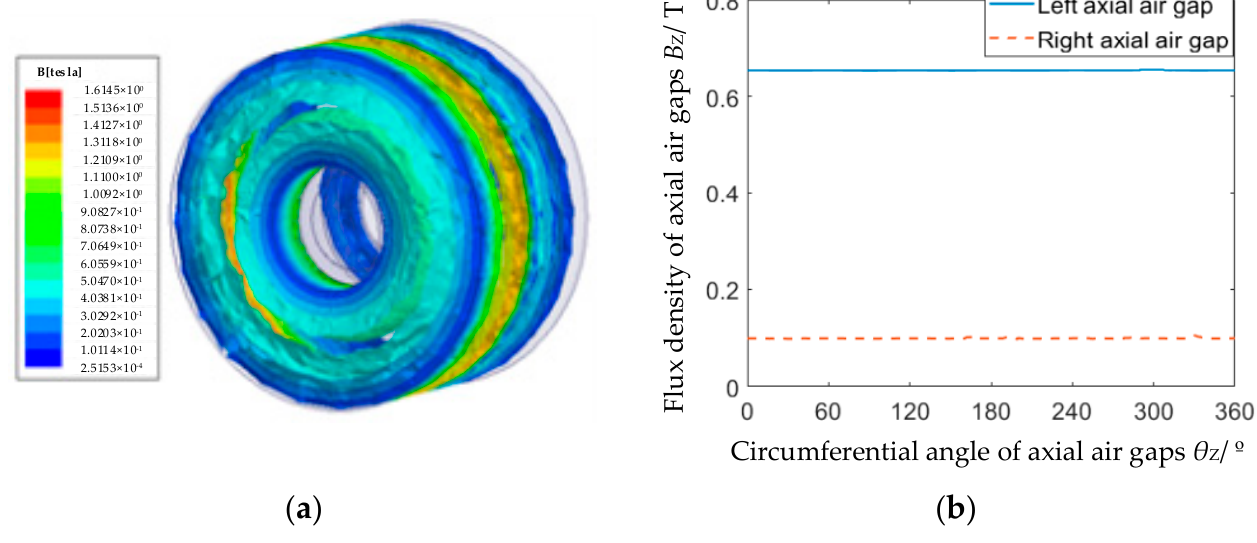
Figure 8. FE analysis results of axial flux density with maximum axial control current. ( a ) Flux distribution of axial stator. ( b ) Flux density in axial air gaps.